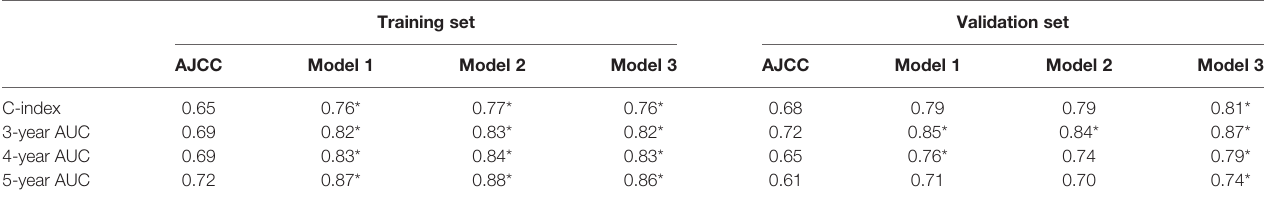
TABLE 4 | Comparison of C-indexes and AUCs between different